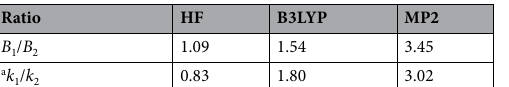
Table 1. The obtained B 1 / B 2 ratio from the QM/MM MD simulations at the HF/aug-cc-pVTZ/Amberff99SB, B3LYP/aug-cc-pVTZ/Amberff99SB, and MP2/aug-cc-pVTZ/Amberff99SB QM/MM levels. Here, k 1 / k 2 is the ratio of the slope of regression curves for the QM/MM interaction energies relative to the electric fields, and k 1 and k 2 are the slopes that correspond to the green and blue lines in Fig. 7, respectively. a Unsigned values are adopted.